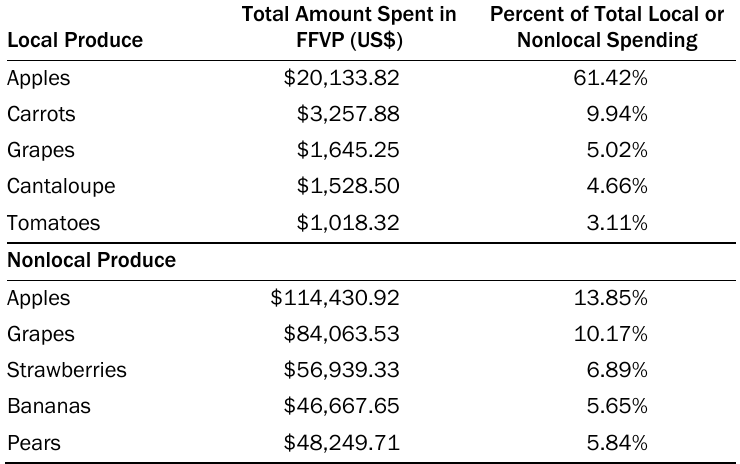
Table 4. Most Purchased Fresh Fruits and Vegetables by Schools